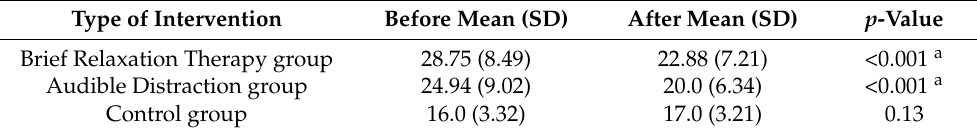
Table 2. Effectiveness of the intervention by pre-and post- intervention mean anxiety scores.